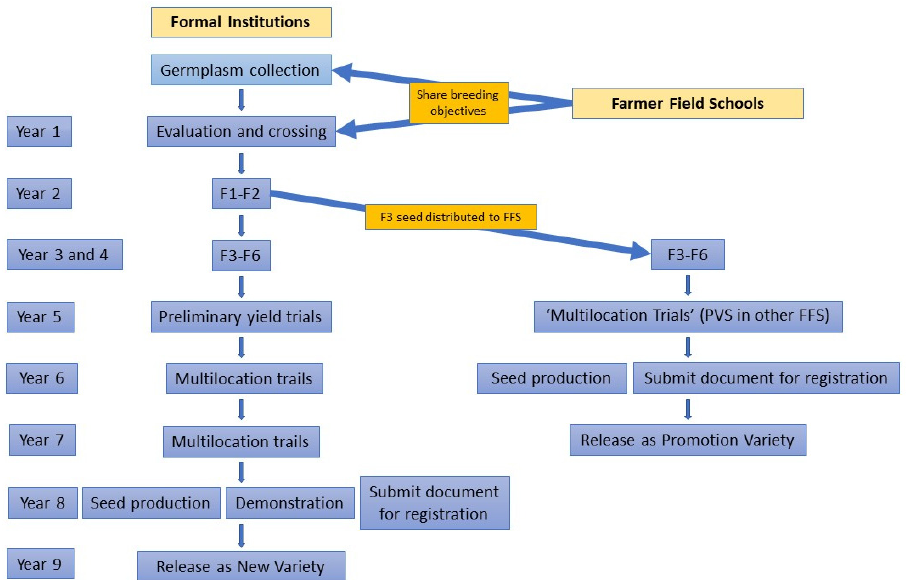
Figure 3. Comparison between the formal breeding and variety release process (left) and the new provincial release process based on participatory plant breeding and variety selection (right). Source: the authors.